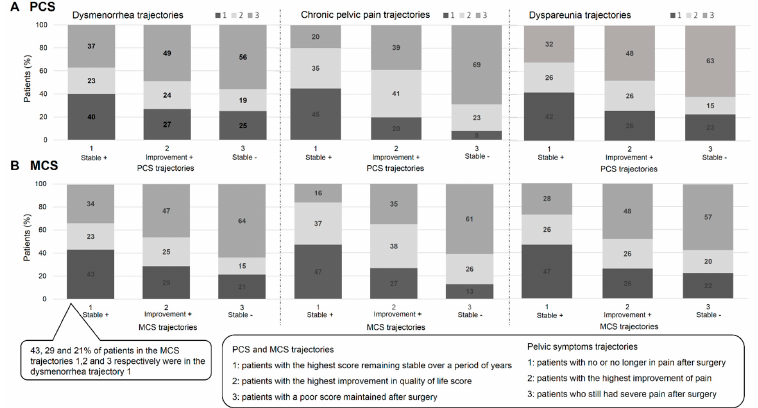
Figure 3. Comparison of pelvic pain and quality-of-life trajectories. ( A ) PCS score; ( B ) MCS score. MCS: mental component summary; PCS: physical component summary. Cpp: 45%, 41% and 69% of patients in the PCS Stable +, Improvement + and Stable − trajectories respectively were also in the Cpp Stable +, Improvement + and Stable – Cpp trajectories respectively (Figure 3A). Dyspareunia: 42%, 26% and 63% of patients in the PCS Stable +, Improvement + and Stable – trajectories respectively were also in the dyspareunia Stable +, Improvement + and Stable − trajectories respectively (Figure 3A).